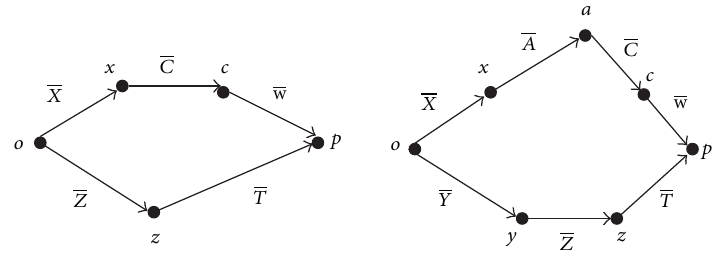
Figure 2: Example of kinematic scheme XCFZ - XACFYZ .